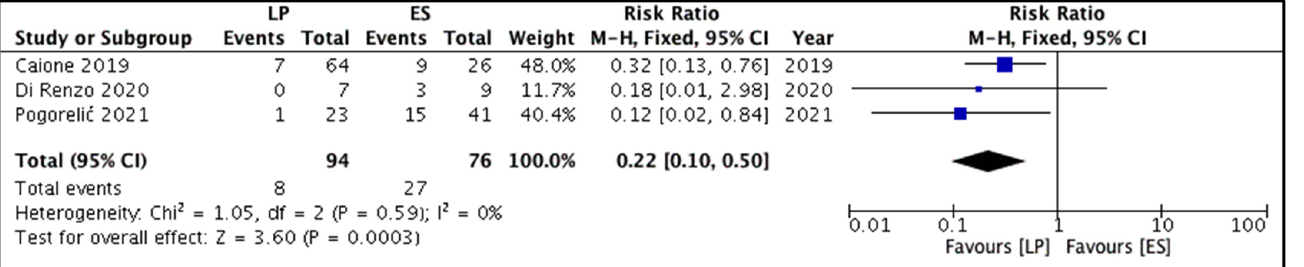
Figure 5. Forest plot comparison between the two patient groups in terms of the requirement for anti-reflux surgeries (excluding other secondary procedures). Legends: LP, laser puncture patient group. ES, electrosurgical incision patient group. M-H, Mantel-Haenszel method. CI, confidence interval.